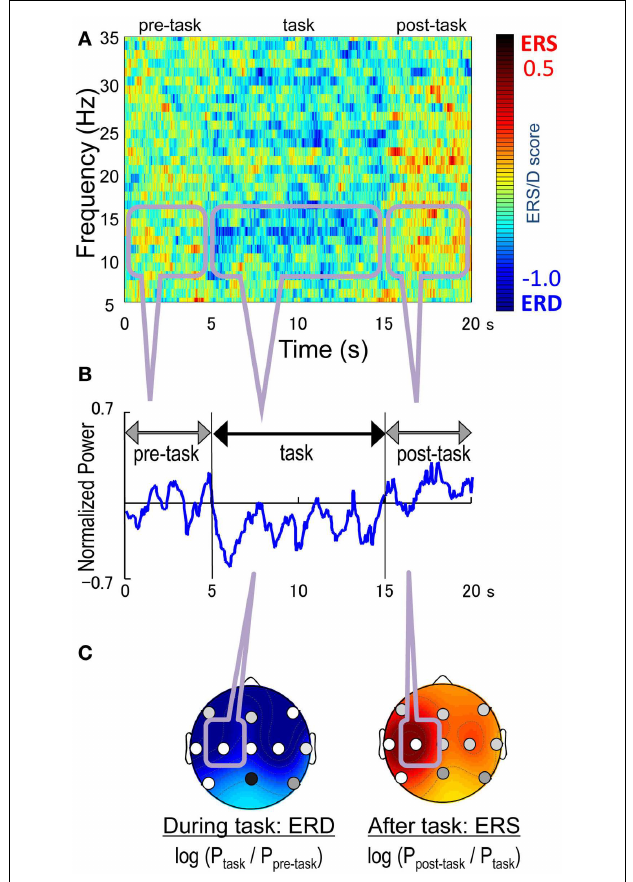
FIGURE 1 |The peak and average frequency analysis during right finger-tapping. (A) the normalized power spectrum obtained by a fast Fourier transform (FFT) at C3, (B) an example of the averaged power of the EEG oscillation at C3 (C) ERD/ERS patterns.The peak frequency was the frequency with the strongest power in